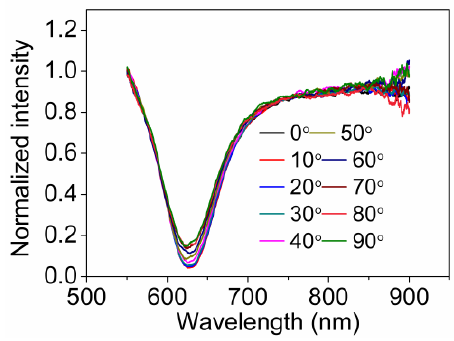
Figure 6. Normalized SPR spectrums at each polarization azimuth.